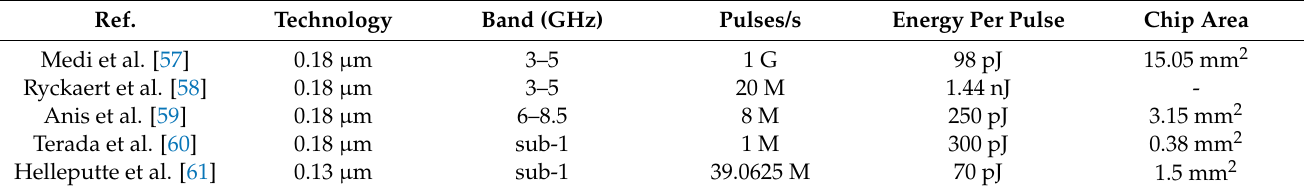
Table 3. Parameters of UWB pulse radio